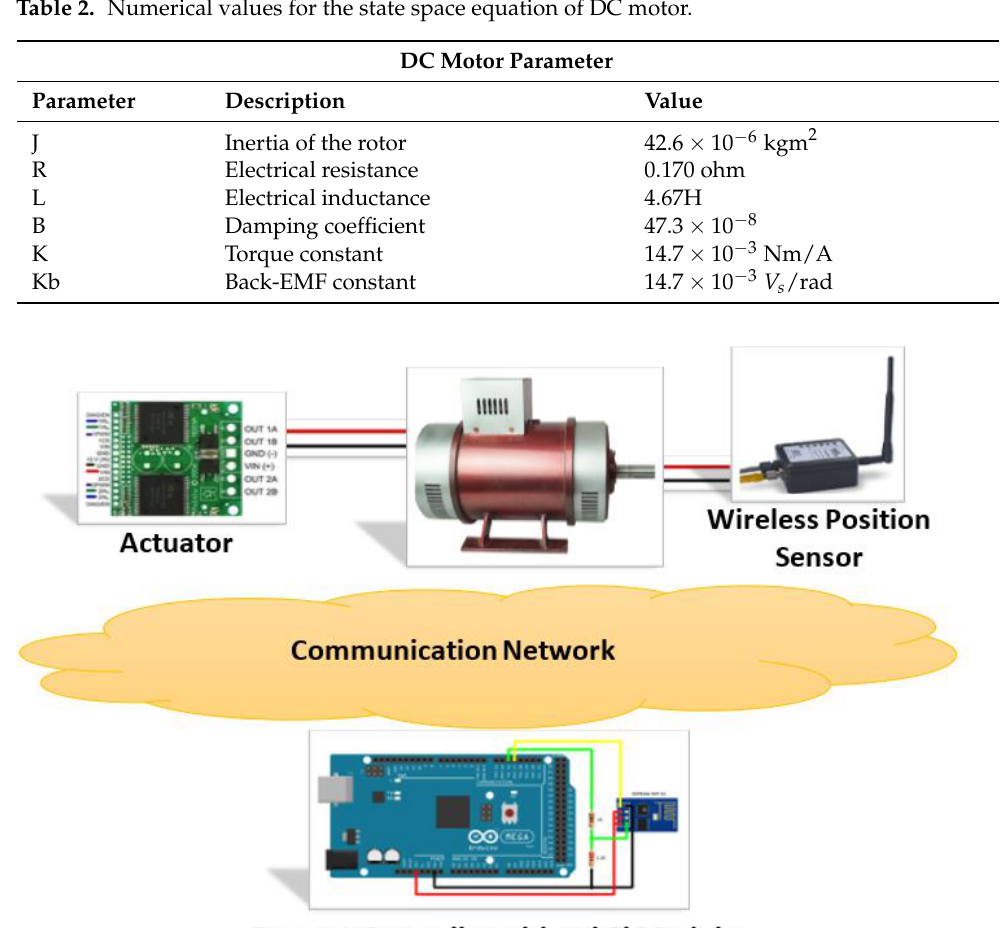
Figure 3. Networked DC motor control